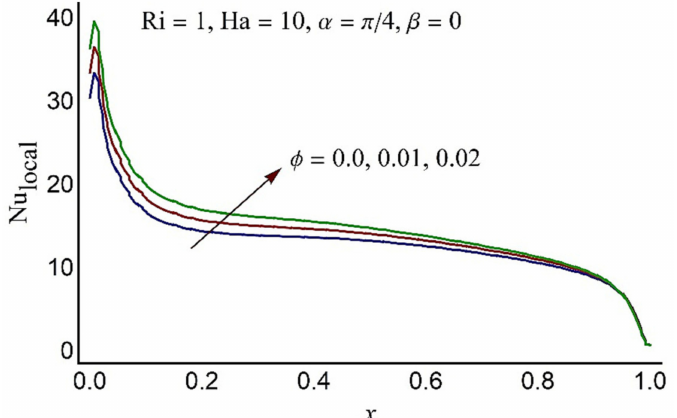
Figure 11. The local Nusselt number at the top wall for various φ hnf against